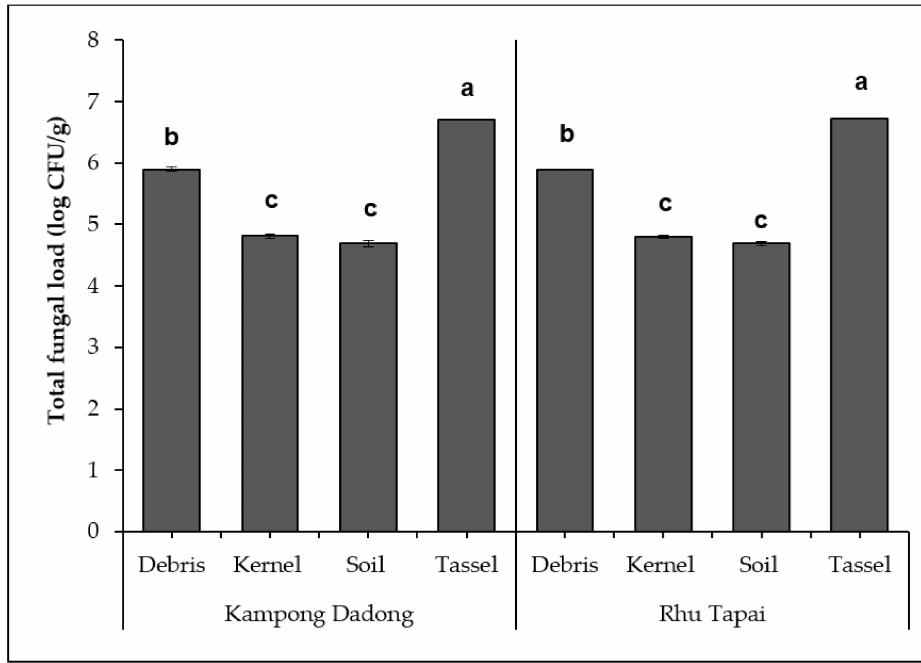
Figure 1. Total fungal loads (colony-forming unit; log CFU/g) of debris, kernel, soil, and tassel samples obtained from Kampong Dadong and Rhu Tapai grain corn farms in Terengganu following dilution plating on dichloran rose bengal chloramphenicol agar (DRBC) and incubation at 30 ◦ C for seven days. Data are means of triplicate ( n = 3) with bars indicating a standard error ( ± SE). Different letters indicate a significant difference ( p < 0.05) by Tukey’s honest significant difference (Tukey’s HSD). a,b,c = Different letters indicate a significant